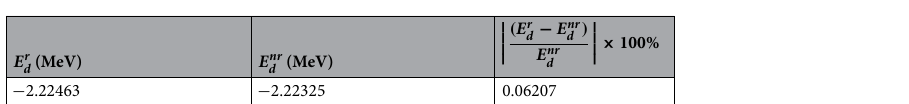
E r d Table 2. Calculated deuteron binding energy for relativistic and nonrelativistic CD-Bonn potentials and their relative percentage difference.